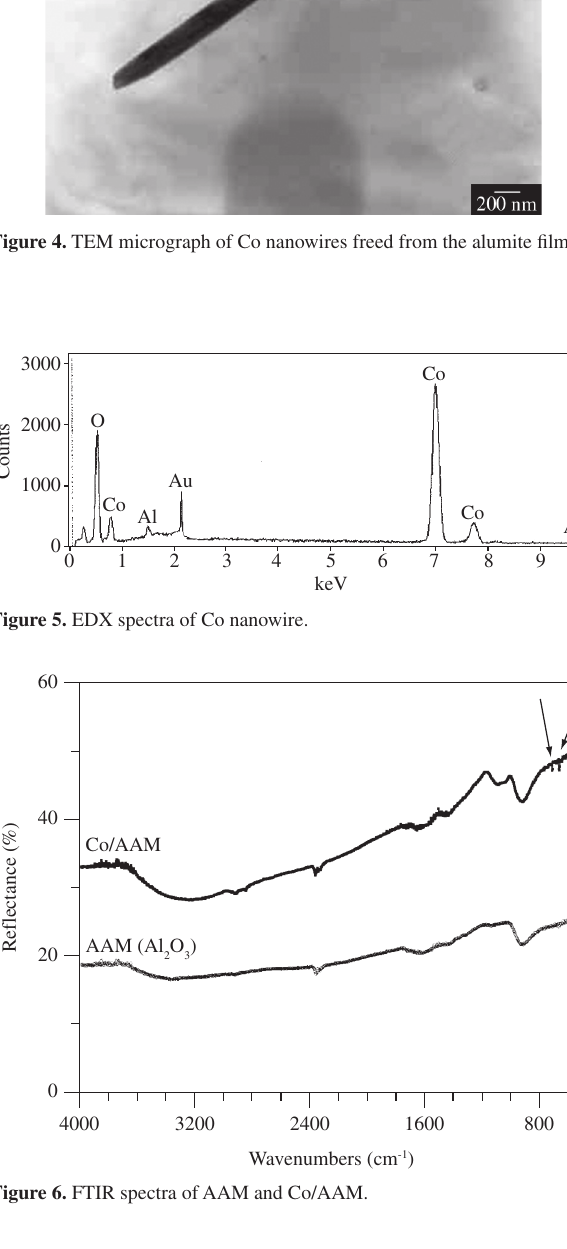
of cobalt nanowires into pores of the anodic alumina. FTIR spectra showed two peaks at 665 and 703 cm -1 , which are attributed to the presence of cobalt oxide in the